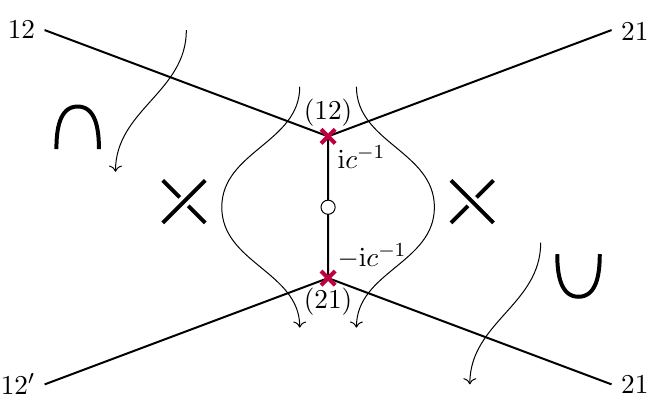
Figure 8 . Spectral curve for two punctures in su 2 and interface paths. A puncture in the center corresponds to z = 0 where strand positions